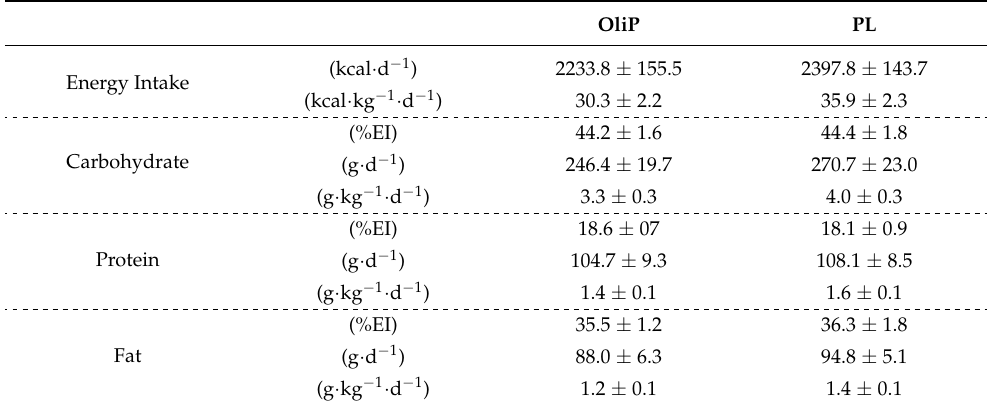
Table 4. Mean dietary intake across the 16-day intervention for those consuming OliPhenolia ® (OliP) or a matched placebo